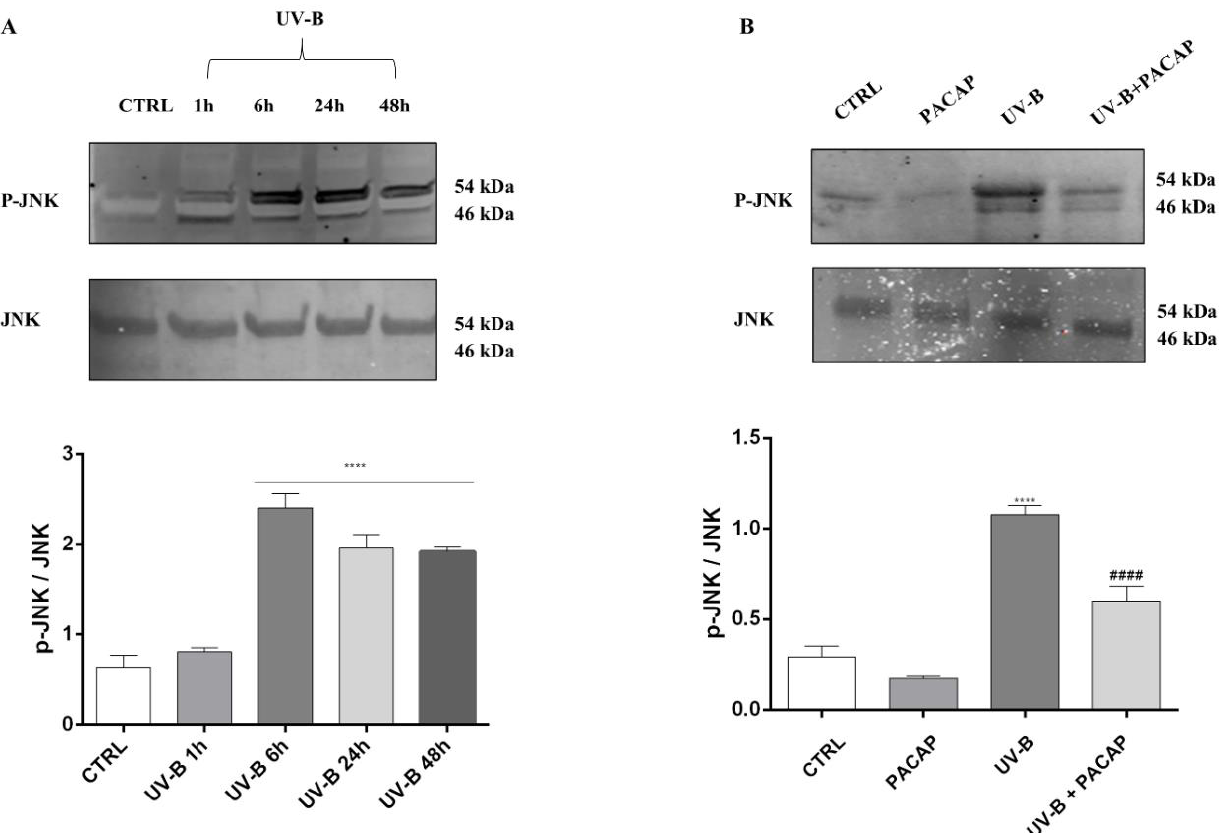
Figure 6. ( A ) JNK activation induced by UV-B at different time points. ( B ) JNK phosphorylation expression at 6 h. **** p < 0.0001 vs. CTRL; #### p < 0.0001 vs. UV-B.